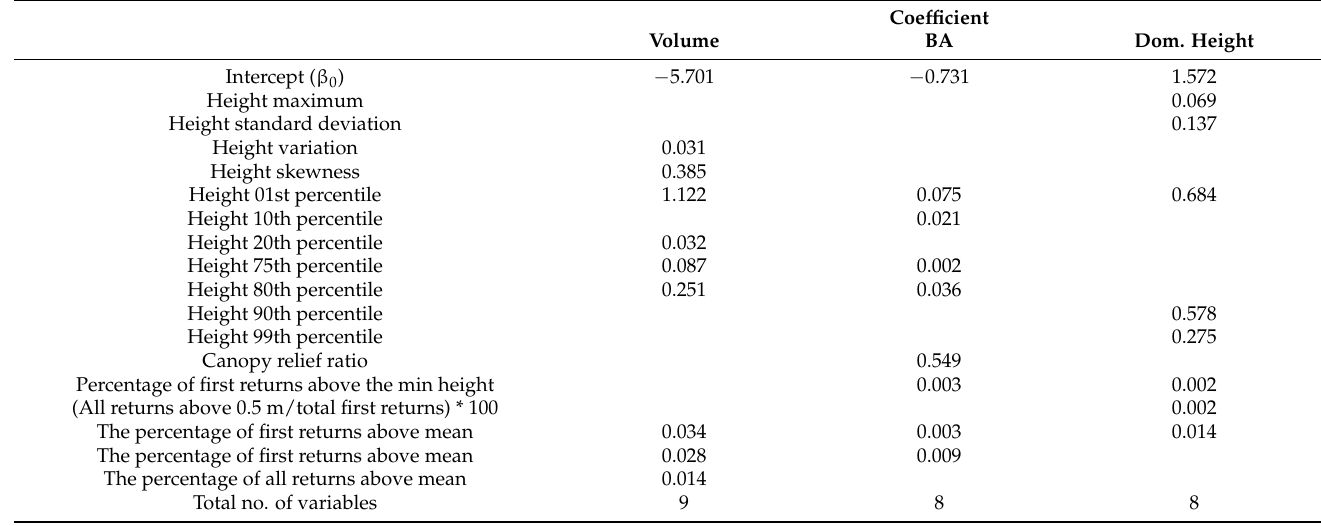
Table 6. List of variables and their coefficients selected for volume, BA, and dominant height model by adaptive lasso regression